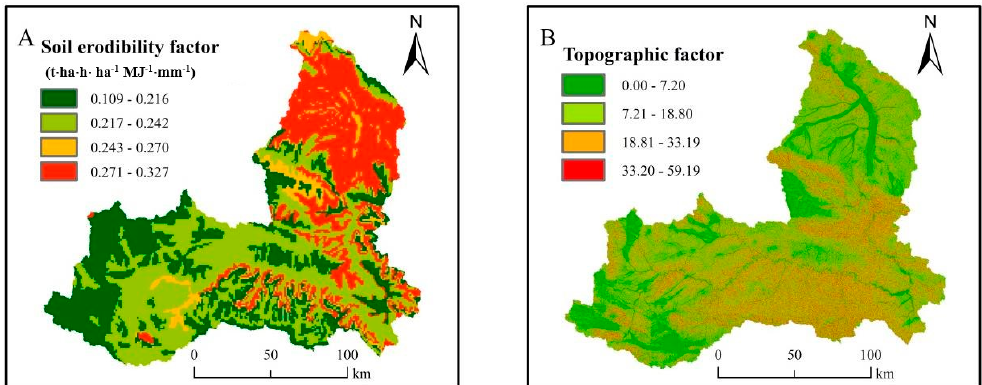
Figure 3. Spatial distribution of soil erodibility factor and topographic factor in the Taohe River